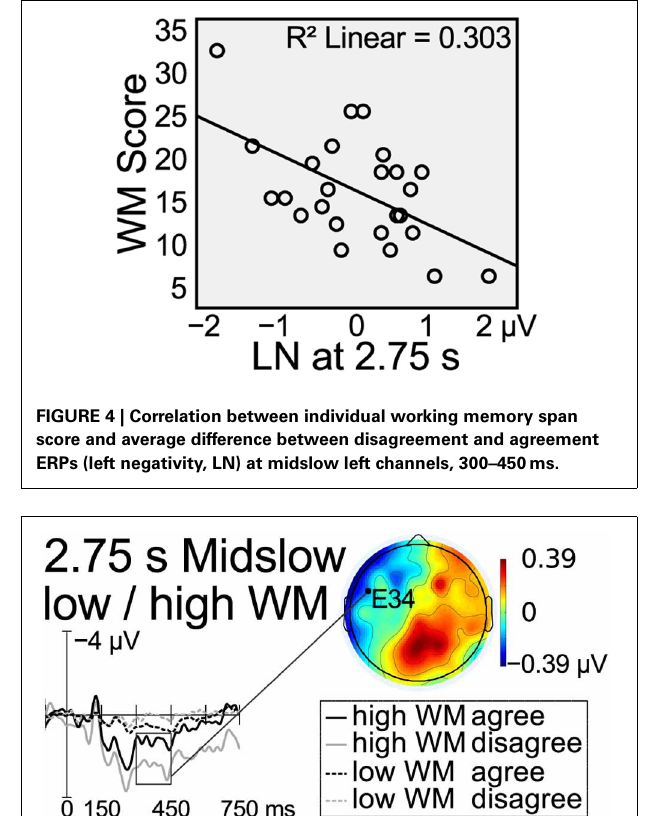
working memory span, showing a left-lateralized negativity only in participants with greater